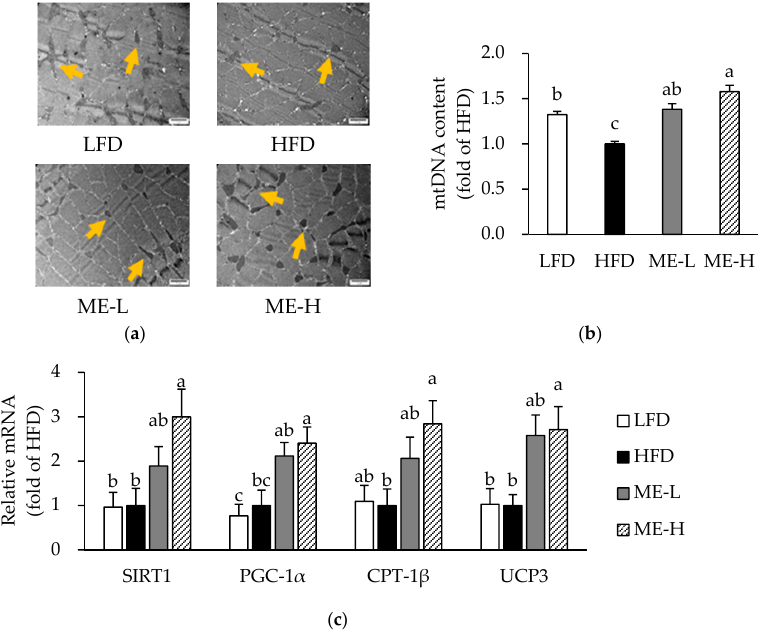
Figure 5. Effect of mulberry fruit extract on skeletal muscle mitochondria. ( a ) Representative transmission electron microscopic images. Magnification of 20,000. Scale bars = 2 μ m. Arrows indicate mitochondria. ( b ) mtDNA content in skeletal muscle. The content was determined by measuring the mitochondrial gene, Cox1 (subunit 1 of cytochrome oxidase) relative to the nuclear gene, and GAPDH (glyceraldehyde 3-phosphate dehydrogenase). ( c ) mRNA expression of genes involved in mitochondrial function. The mRNA levels were normalized relative to the β -actin. Values are expressed as mean ± SEM (n = 8/group). Bars with different letters indicate a significant difference at p < 0.05. Abbreviations: LFD, low-fat diet; HFD, high-fat diet; ME-L, HFD + 5 g/kg diet of mulberry fruit extract; ME-H, HFD + 10 g/kg diet of mulberry fruit extract; and mtDNA, mitochondrial DNA.